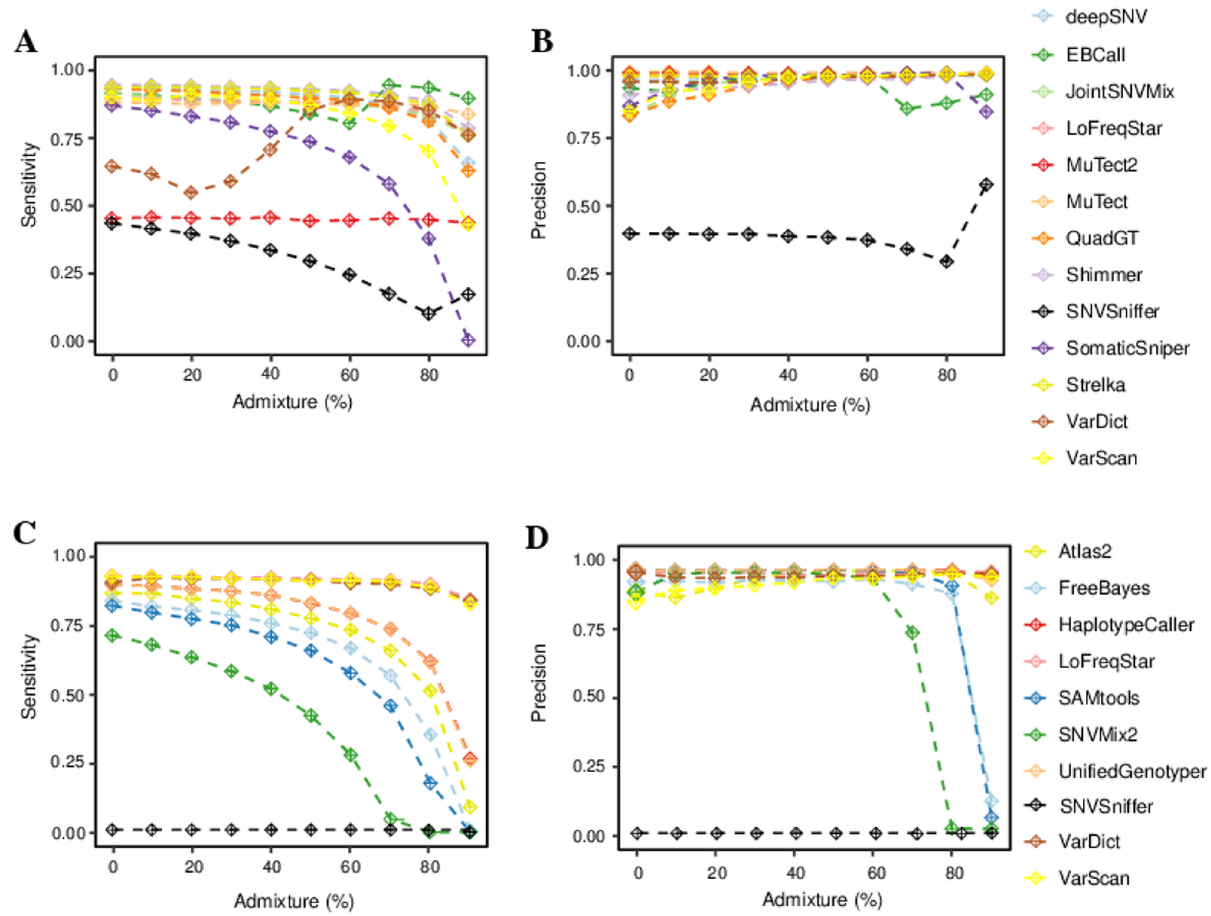
Fig 5. Benchmarking results for somatic SNVs on targeted gene panel data. A and C. Sensitivity; B and D. precisionfor somatic SNVs. A, B. on pairedtumor-control targeted gene panel data; C, D. on singletumor targeted genepanel